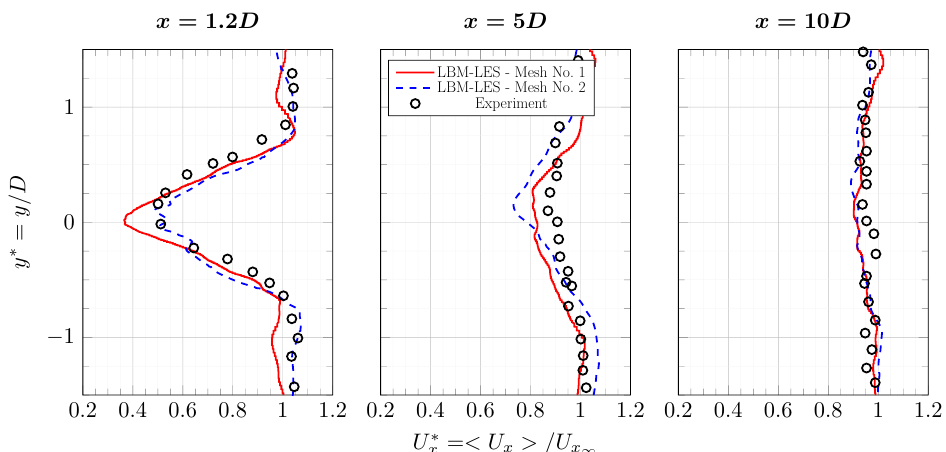
Figure 19. Average axial velocity profiles in the wake of the tidal turbine at TSR = 3.67 and I = 12.5%. Results are from experiment [6] and from LBM-LES simulations with mesh Nos. 1 and 2. The complete set of profiles is in Appendix